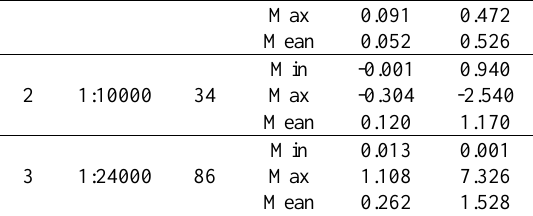
Table 3. The accuracy of the DSM comparison The results can be summarized as